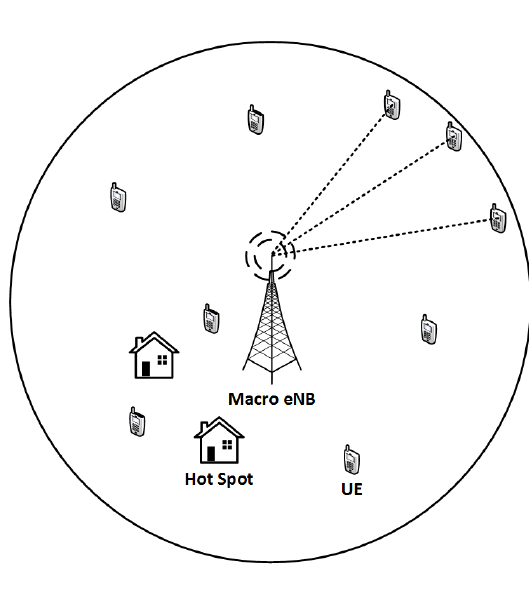
Figure 1. Original Scenario Figure 2. Centroid Scenario